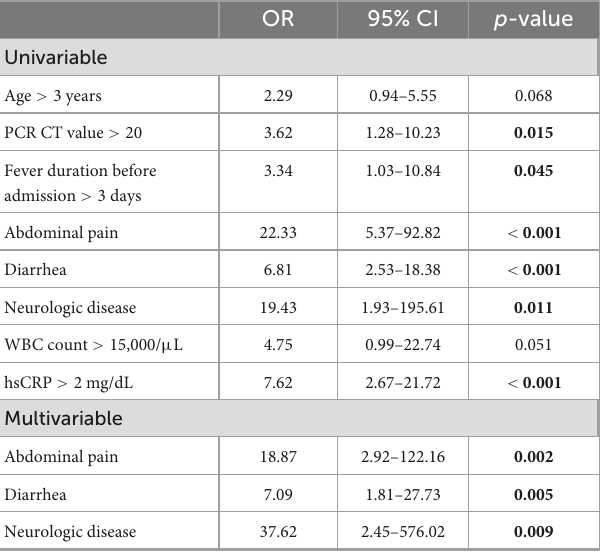
TABLE 4 Univariable and multivariable logistic regression analyses of COVID-19 with bacterial coinfections. OR 95% CI p